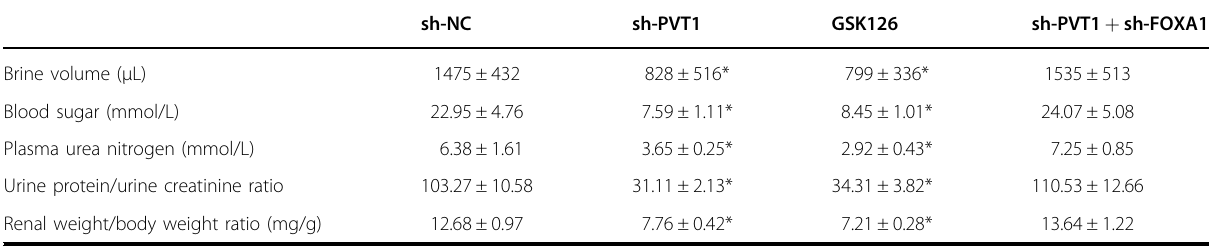
Table 3 Comparison of the urine indexes of mice in each group